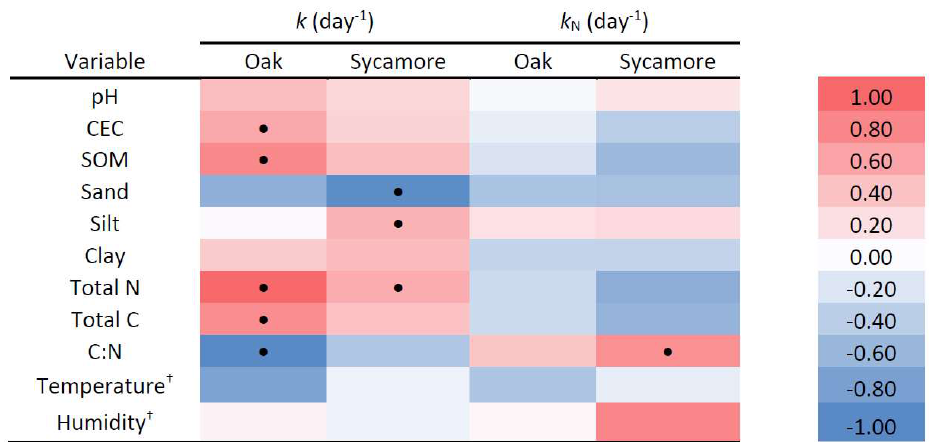
Figure 5. Pearson-product correlation coefficients for decomposition statistics as a function of soil physical and chemical properties. Cells with a black dot ( • ) indicate a statistically significant ( p < 0.05) correlation (n = 35). CEC = cation exchange capacity; SOM = soil organic matter. Data from soil temperature and humidity are from only 3 of the 7 participating institutions (n = 14).